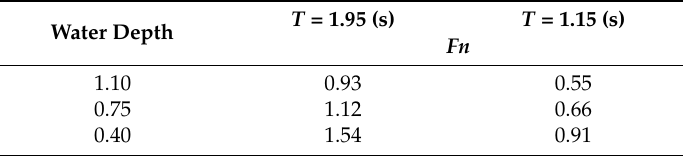
Table 2. Froude number in three water